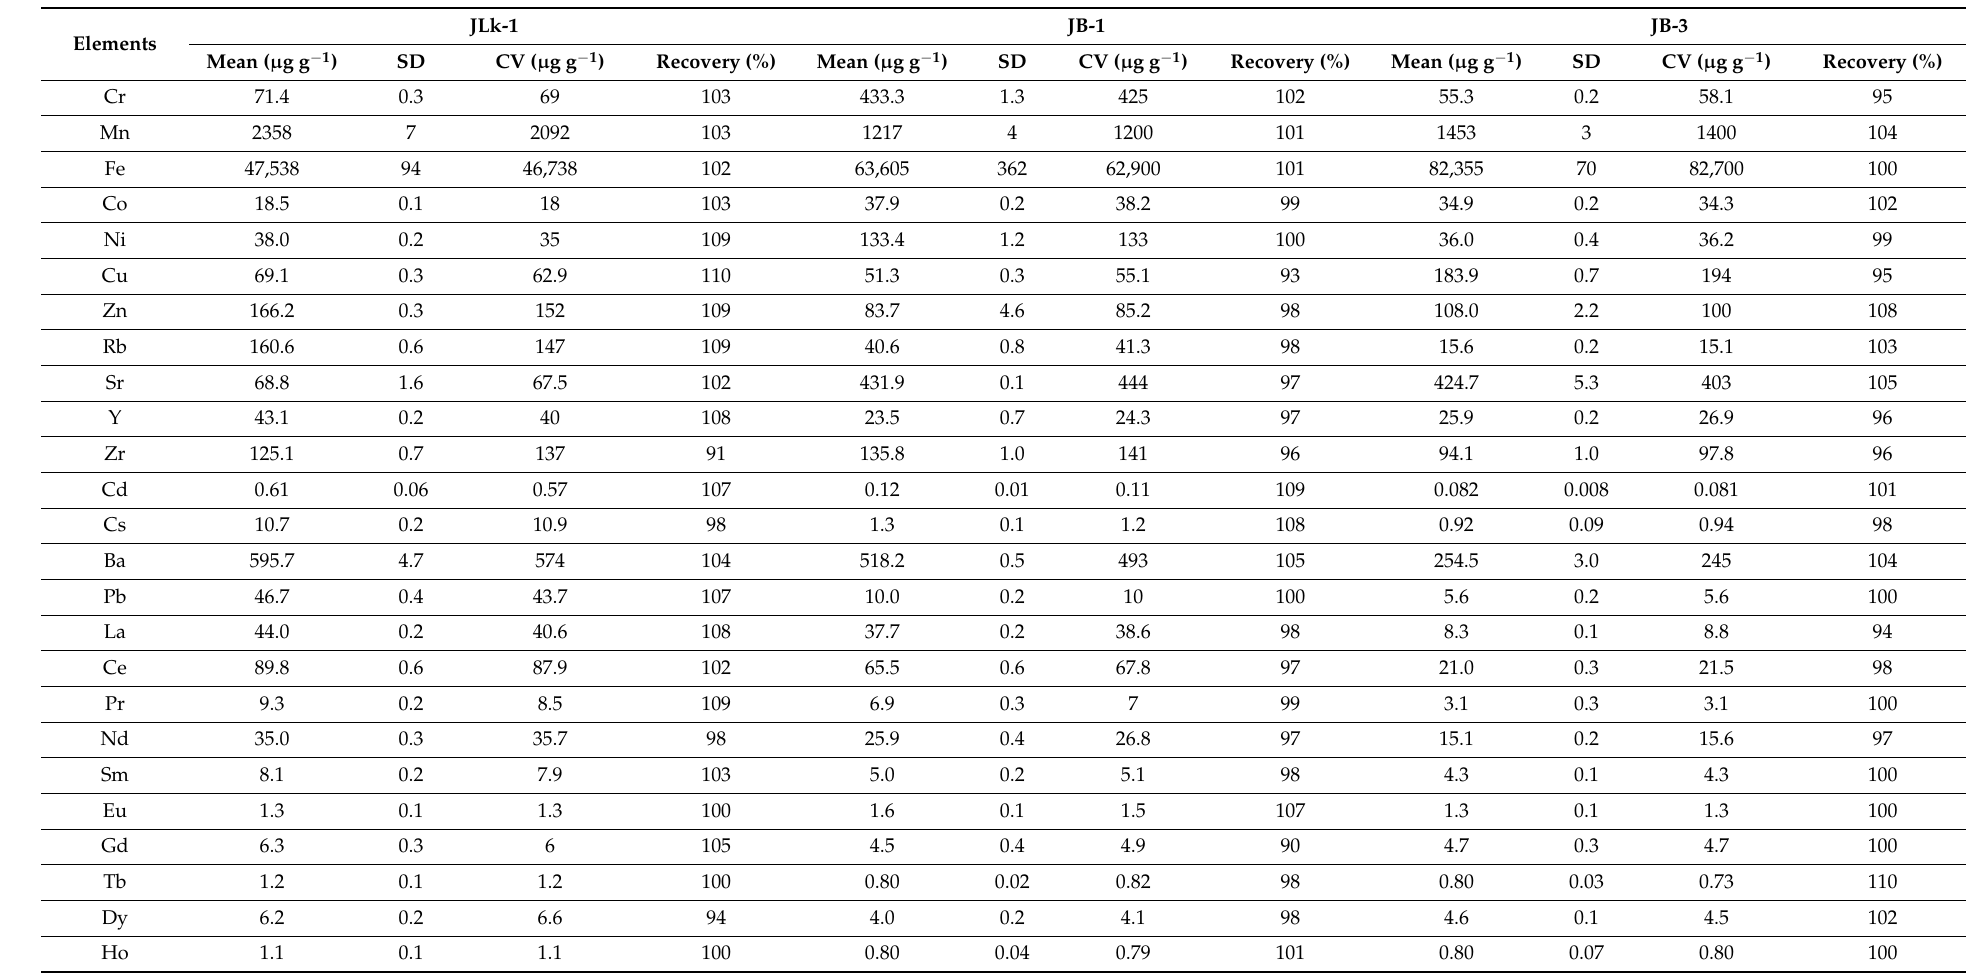
Table 1. Analytical results of TEs and REEs ( µ g g − 1 ) for JLk-1, JB-1 and